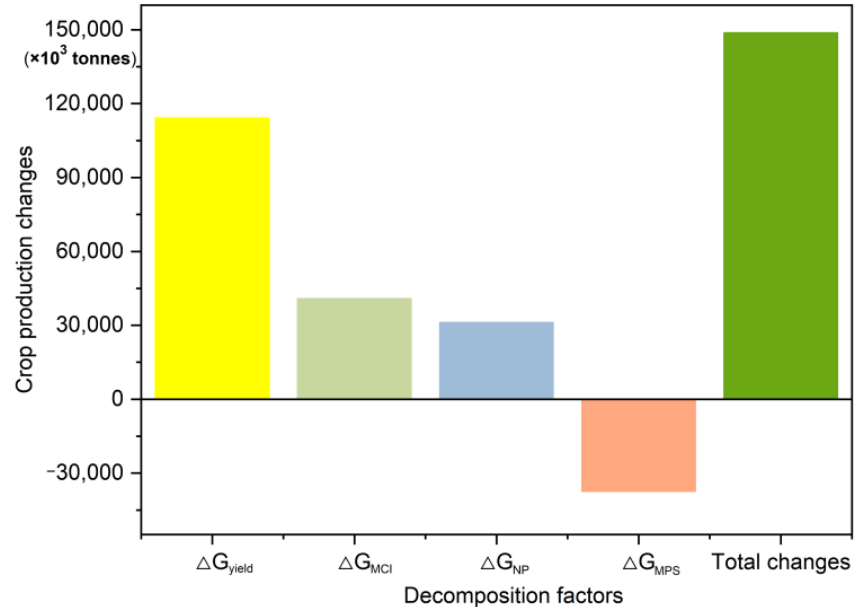
Figure 6. Factor decomposition of the total change in crop production across China between 2000 and 2010, considering the contributions of yield ( ∆ G yield ), multiple cropping index (MCI, ∆ G MCI ), number of parcels (NP, ∆ G NP ), and mean parcel size (MPS, ∆ G MPS ).